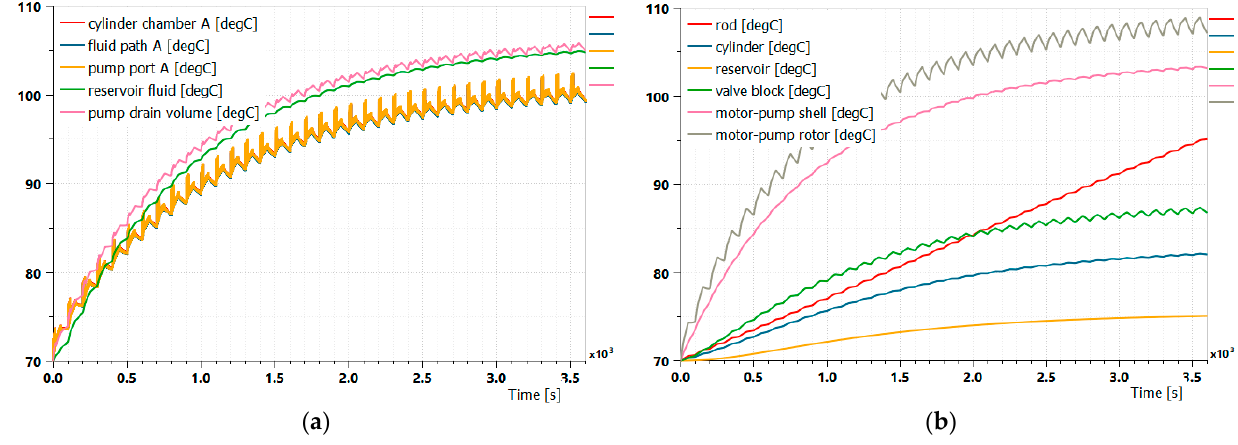
Figure 12. The simulation results of the temperature responses. ( a ) The temperature responses of the fluid nodes. ( b ) The temperature responses of the solid nodes.